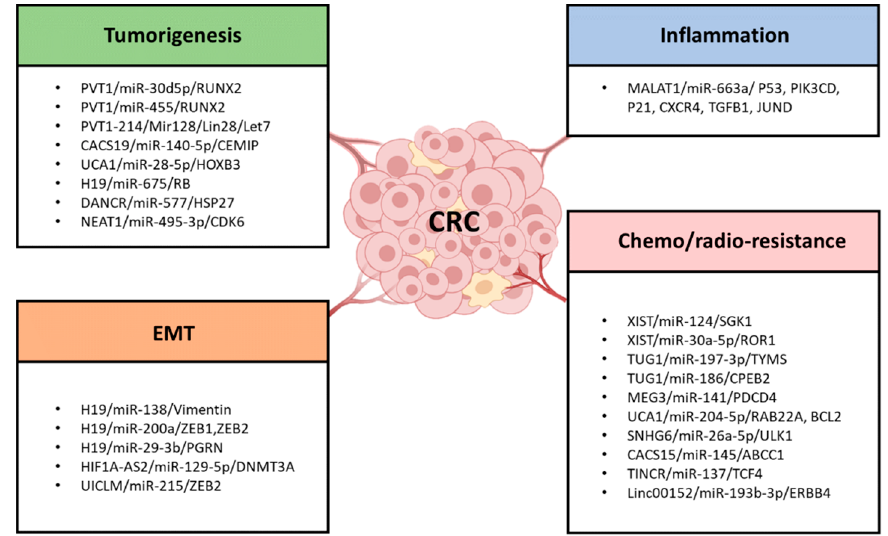
Figure 3. The lncRNA-associated ceRNA networks affect the four common hallmarks of colorectal Representative lncRNA-miRNA-mRNA networks are listed, which highlighted the involvement of cancer. Representative lncRNA ‒ miRNA ‒ mRNA networks are listed, which highlighted the lncRNA-ceRNAnetworksinfourmajorhallmarksofCRC:tumorigenesis, EMTformation, inflammatory involvement of lncRNA-ceRNA networks in four major hallmarks of CRC: tumorigenesis, EMT process and chemo- / formation, inflammatory process and chemo-/radioresistance.